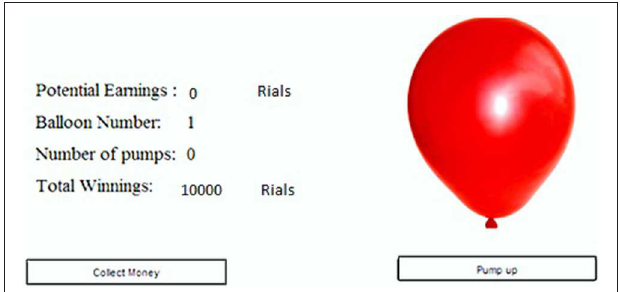
FIGURE 1 | Display panel in the BART. The balloon was expanded by clicking on the “Pump up” button. Each click added 100 Rials (equivalent to 10 ¢ ) to the “potential earnings.” By clicking on “collect money” button, the money accumulated thus far in “Potential Earnings” was transferred to “Total winnings.” If the balloon is exploded, the money in the “potential earnings” was subtracted from the “Total winnings.” The “Balloon number” indicates the trial